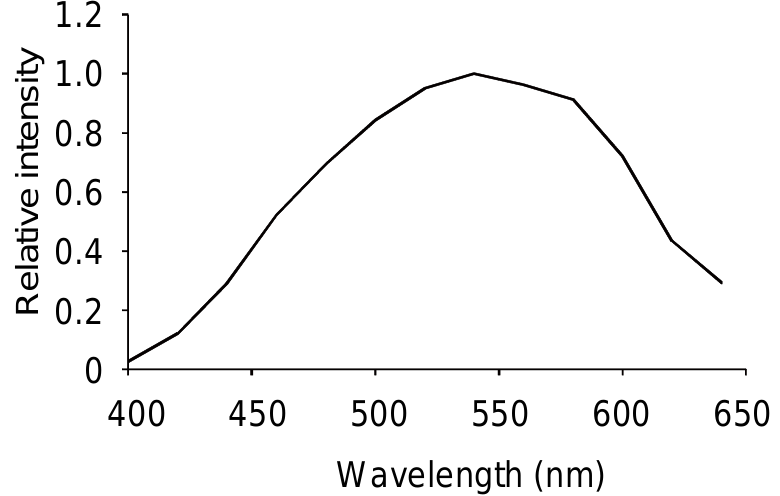
Figure 4. Luminescence spectrum of the albumin–luciferin reaction. When the human albumin was heat-denatured, the